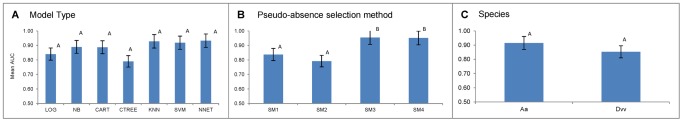
Variation of mean AUC values due to model type, pseudo-absence selection method and number and structure of presence data.Error bars indicate standard errors over replicates. Bars with same letters within a graph are not significantly different (Tukey’s HSD test p>0.05). (A) model type, (B) pseudo-absence selection method, and, (C) species dataset.